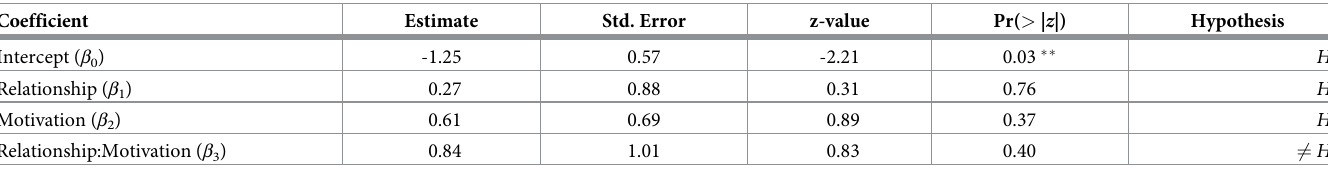
Table 5. Summary of coefficient estimates for full GLM model (Eq